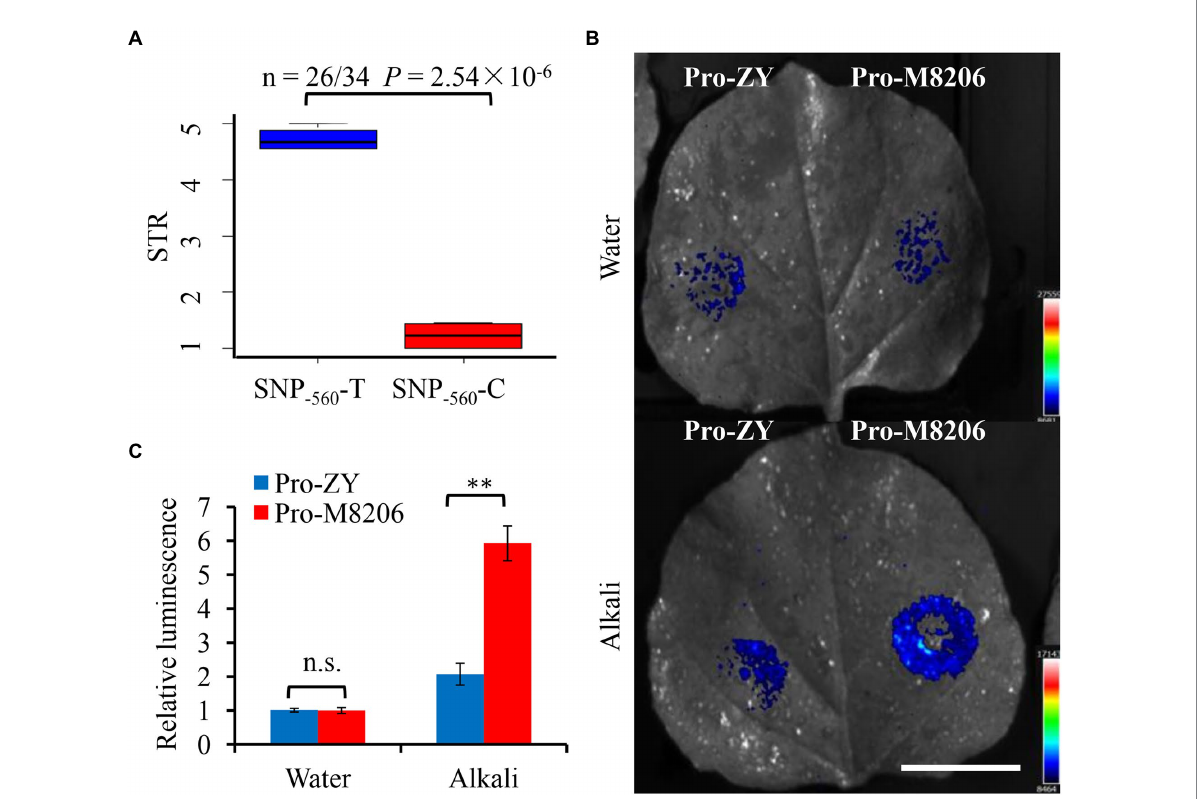
FIGURE 6 Natural variation and activity of soybean NHX6 promoter. (A) Boxplot of STR for two alleles of SNP in GmNHX6 promoter among 60 soybean − 560 accessions. n denotes number of accessions. Statistical significance was detected by two-sided Wilcoxon test. The center bold line represents the median; box edges indicate the upper and lower quantiles; whiskers show the 1.5 × interquartile range. STR: sodic (alkaline salt) tolerance rating. (B,C) Promoter activities of two types of GmNHX6 promoters by luciferase (LUC) transient expression assays in tobacco leaves after alkaline salt (100 mM NaHCO 3 ) treatment for 16 h. Pro-M8206 contains SNP -C and Pro-ZY contains SNP -T. The LUC reporter gene was driven by each − 560 − 560 type of promoter. The photos were taken using an in vivo plant imaging system. Bar = 3 cm. Data represents the mean ± standard deviation of four biological replications with two repeats within each replication ( n = 4 × 2 = 8). Differences were evaluated using the two-tailed Student’s t -tests ( ** p < 0.01; n.s., not